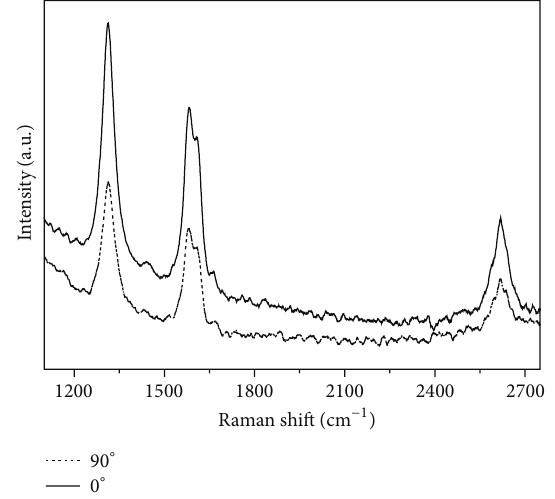
Figure 4: Polarized Raman spectra of composite with aligned MWCNTs of 6vol. %.